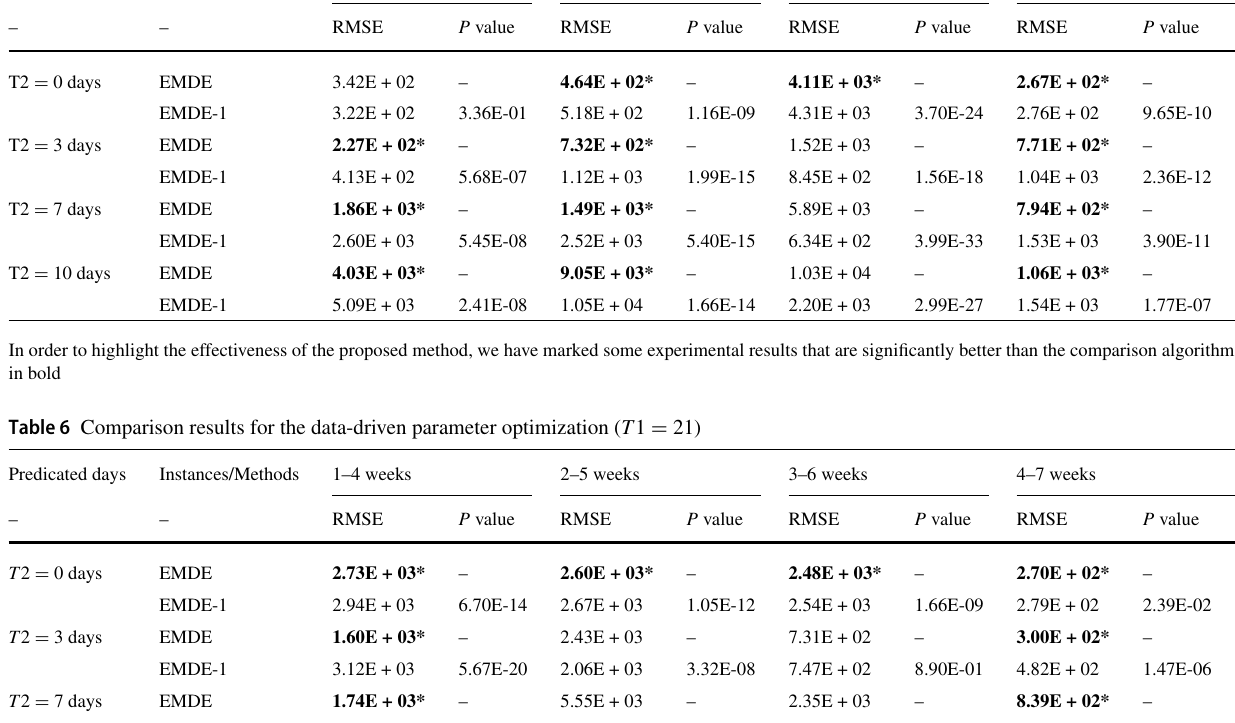
Table 5 Comparison results for the data-driven parameter optimization ( T 1 (cid:2) 7) Predicated days